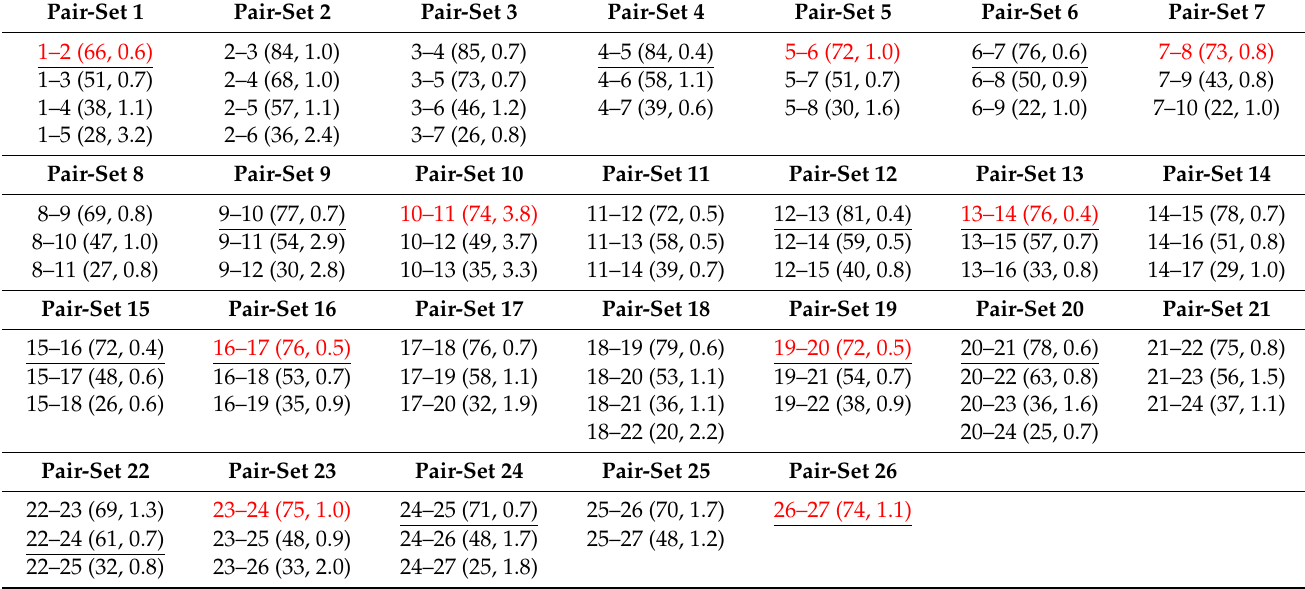
Table 2. Initial-image pairs and the results of optimal-image selection for the first strip (red font: the minimum pairs; underline: the best accuracy pairs). Each cell shows an image ID with overlap ratio and magnitude of Y-parallax error in parentheses.